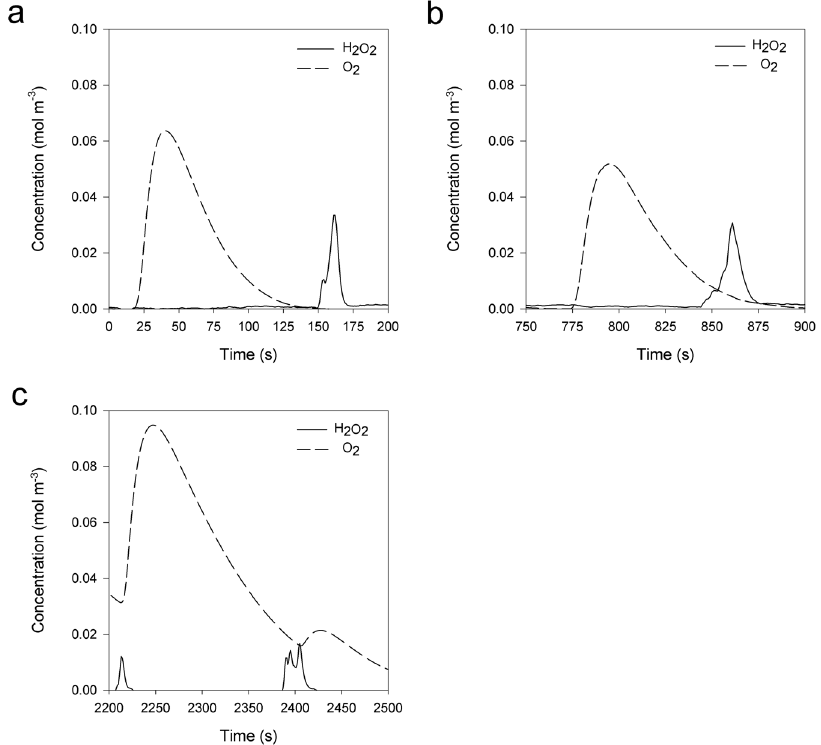
Fig. 2 | Dynamics of hydrogen peroxide (H 2 O 2 ; solid line) and oxygen (O 2 ; dashed line) in a sediment core. Hydrogen peroxide and oxygen microsensors were at a constant position (4cm depth). a , b Hydrogen peroxide and oxygen